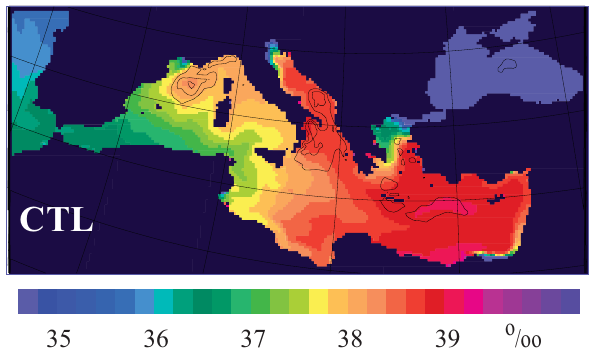
Fig. 3. The colours show the simulated annual mean surface salin- ity in CTL in ‰. Contour interval is 0.2‰. Isolines show the cli- matological maximum depth of the mixed layer. Contour interval is